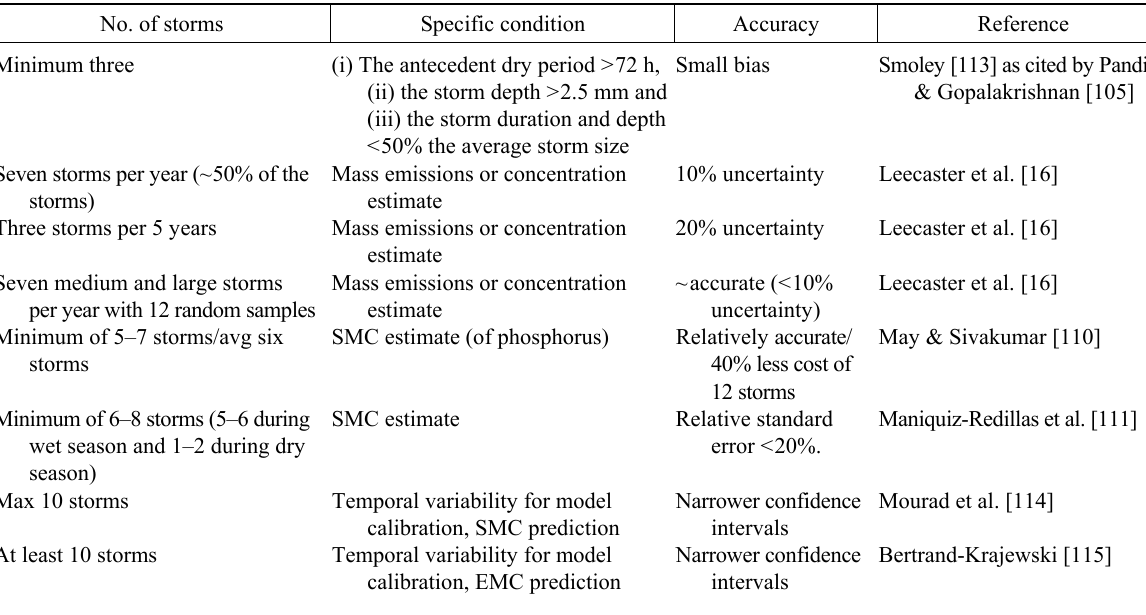
Table 5. Number of storms for sample collection with relative accuracy No. of